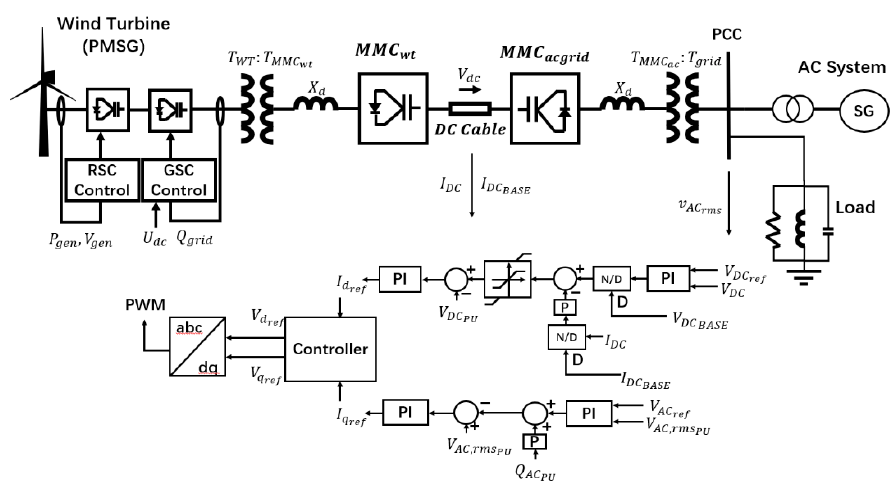
Figure 1. System outline and conventional control loop of modular multilevel-converter high-voltage direct-current (MMC-HVDC).